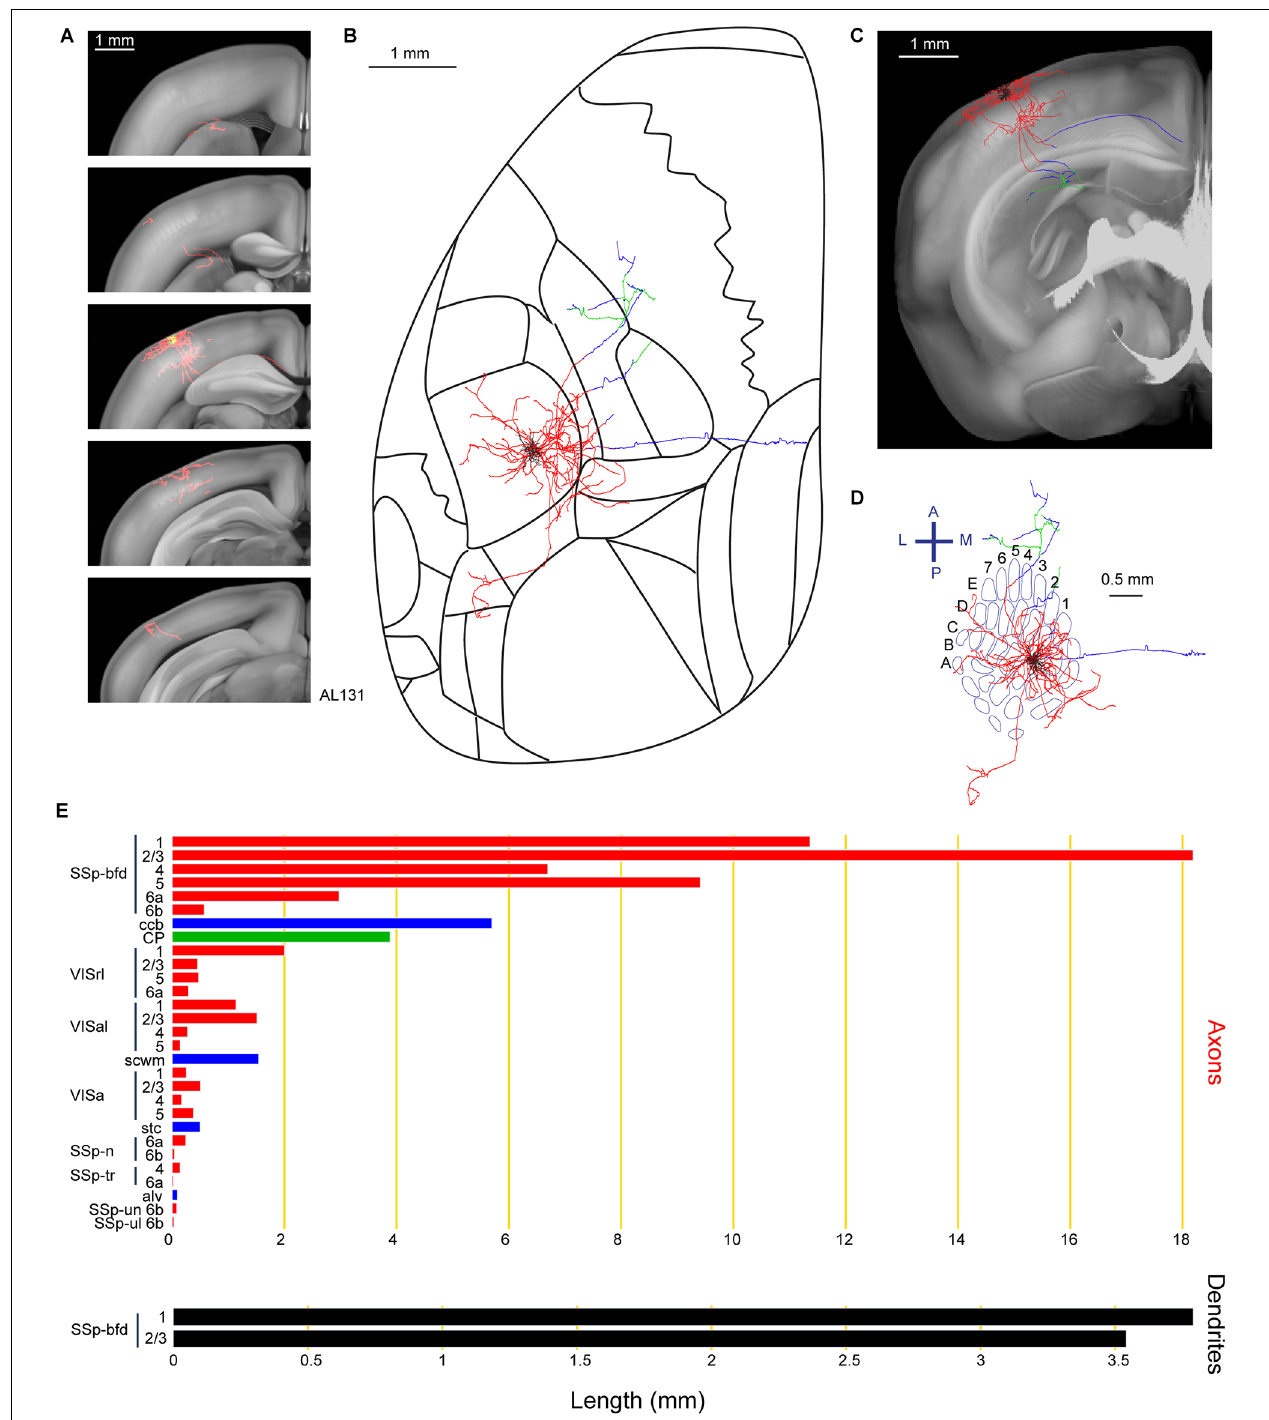
FIGURE 6 | Reconstruction and quantification of example neuron AL131 with projections to the caudoputamen and multiple visual areas. (A) Serial overlays of axon (red) and dendrites (green) in coronal views encompassing the anterior-posterior span of the axons of 4.125 mm. Each section represents a maximum projection of 825 µ m. (B) Maximum projection of the reconstructed axon and dendrites in horizontal view. (C) Maximum projection of the axon and dendrites in coronal view. (D) Maximum projection of the axon and dendrites in tangential view (rotated 30 degrees) over the barrel field. The neuron is in the C2 barrel column. (E) Quantification of axonal (top) and dendritic (bottom) length in respective brain regions identified by the Allen Mouse CCFv3. For (B) to (E) : dendrites are shown in black; axon in neocortical gray matter is shown in red; axon in the striatum is shown in green; axon in white matter is shown in blue.